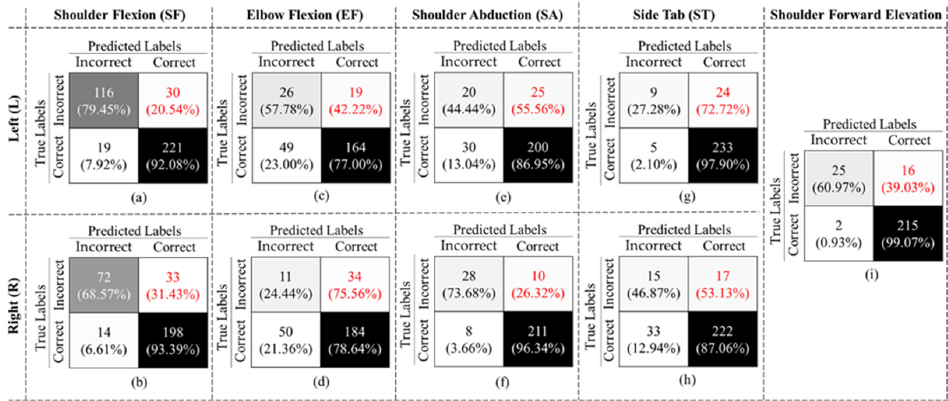
Figure 10. Confusion matrix for models ( a ) SFL, ( b ) EFL, ( c ) SAL, ( d ) SFR, ( e ) EFR, ( f ) SAR, ( g ) STL, ( h ) STR, and ( i ) SFE obtained using the LOSO approach.